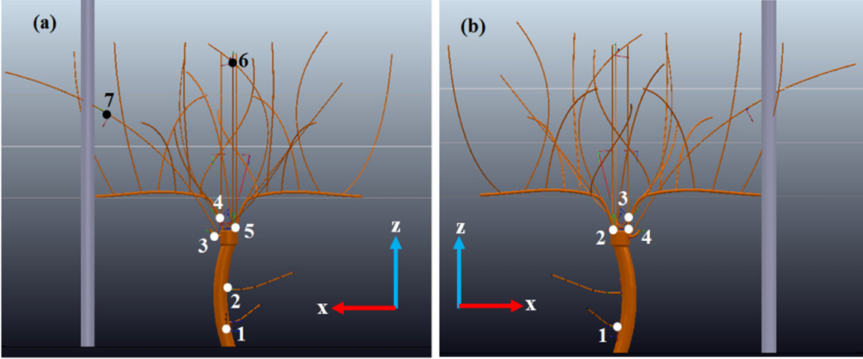
Figure 12. The cut-points of ( a ) the left side of the vine model, ( b ) the right side of the vine model.